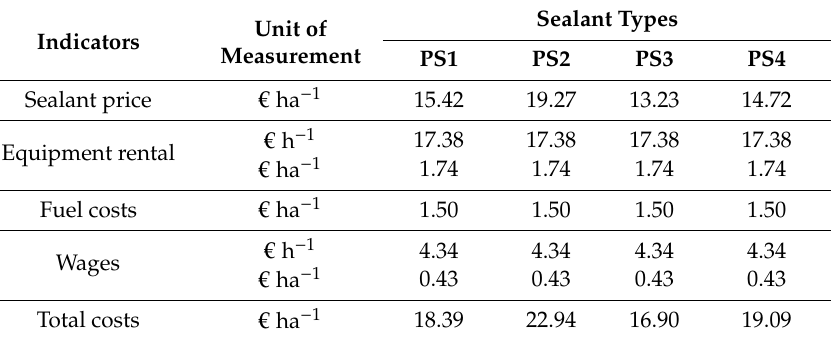
Table 1. Costs Table 1. Costs indicators.